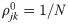
Results for network defined by Eqs (23) and (24) (left panels) and its uncorrelated version defined by Eqs (23) and (26) (right panels).Initially a single bank chosen at random from the network of N = 12000 nodes is defaulted. To obtain analytical results we set ρjk0=1/N (for all j and k). Top panels show the analytical and numerical results for the expected size of global cascades and their frequency versus the default buffer γ. Bottom panels show numerically calculated distributions of cascade sizes for different values of default buffer γ. To obtain numerical results we averaged over 104 realizations of random seeds, and a global cascade occurs if it occupies over 5% of the network.